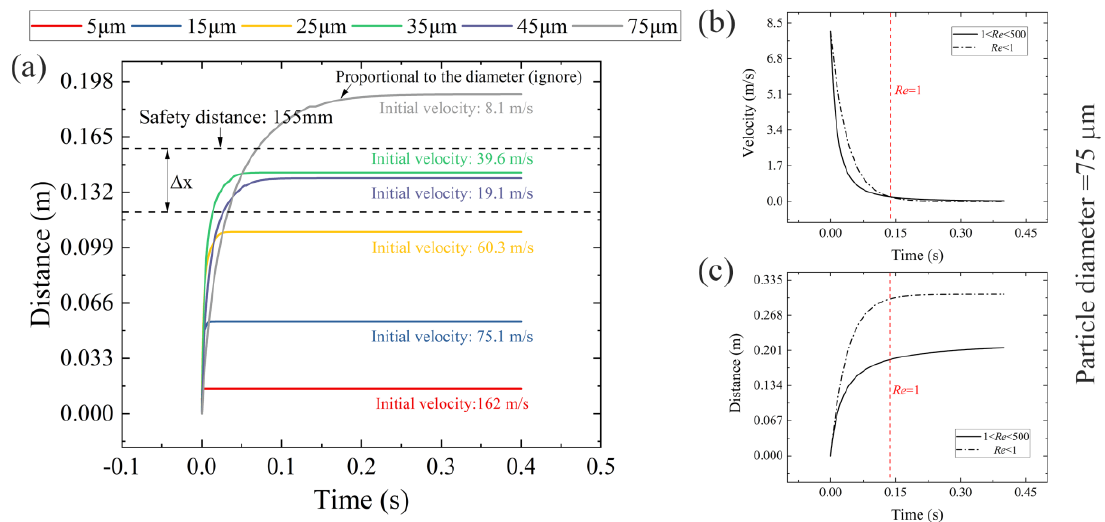
Figure 5. ( a ) Particle’s maximum attenuation distance vs. time calculated by Equation (5) using velocities fitted at 13,000 ns; ( b , c ) are plots of particle velocity and distance vs. time governed by Allen and Stokes regime, respectively, where particle diameter range >50 µ m. Table 2. Time to reach (1) particle terminal velocity, and (2) Re = 1 in the x-direction (longitudinally). Particle Diameter ( µ